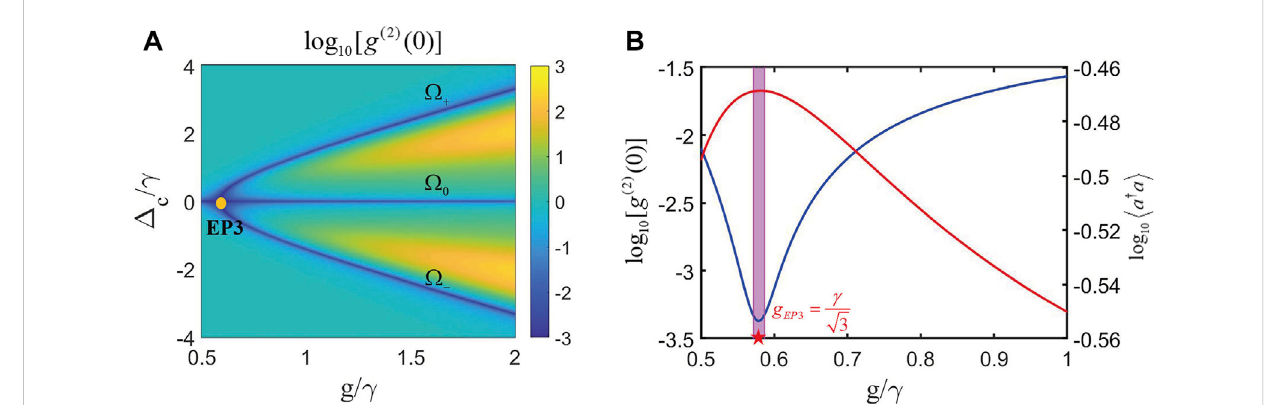
FIGURE 11 EP3-enhanced strong PB effect in the pseudo-Hermitian conditions. (A) Plot of g ( 2 ) ( 0 ) as functions of normalized detuning Δ c / γ and the coupling (cid:8)(cid:8)(cid:8)(cid:8)(cid:8)(cid:8) (cid:20) strength g / γ . EP3 is marked by the red circle. In (B) , the pink dashed area indicates the obvious PB effect at g (cid:1) g EP 3 . We take the parameters as Δ (cid:1) 0 , κ (cid:1) − 2 γ and δ (cid:1) − δ (cid:1) g 2 − γ 2 . c 1 2 4